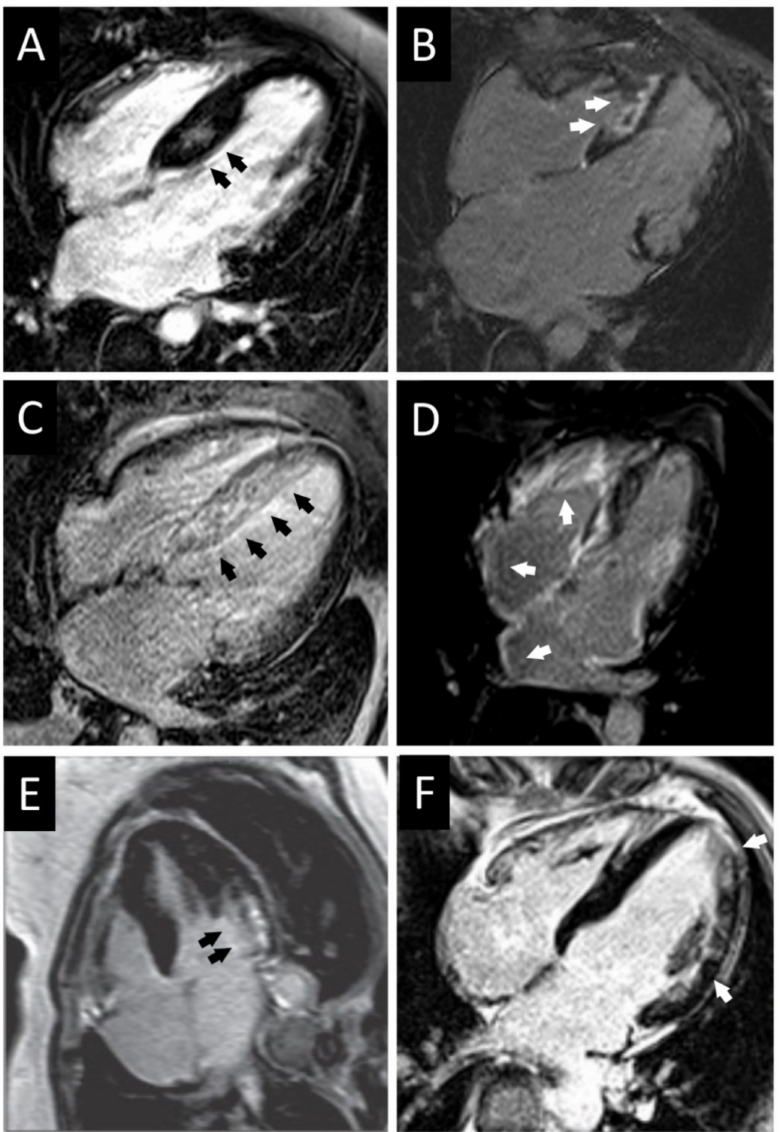
Figure 3. Representative cardiac magnetic resonance findings of patients with obstructive hyper- trophic cardiomyopathy, hypertrophic cardiomyopathy with restrictive phenotype, amyloidosis, and Fabry disease. ( A ) Obstructive HCM with intramural septal LGE. ( B ) HCM with restrictive physiology ( MYH7 variant) with massive septal fibrosis and severe atrial enlargement. ( C ) Light chain immunoglobulin (AL) amyloidosis with transmural septal LGE. ( D ) Wild-type transthyretin (ATTRwt) amyloidosis with LGE particularly in the right ventricle and atria. ( E ) Fabry disease with hypertrophic phenotype and subendocardial LGE at the basal lateral segment of the left ventricle. ( F ) Fabry disease with mild hypertrophy and intramural LGE at the mid-lateral segment of the left ventricle and apex. HCM: hypertrophic cardiomyopathy; LGE: late gadolinium